Question: Judging by this figure, is the value going up or going down?
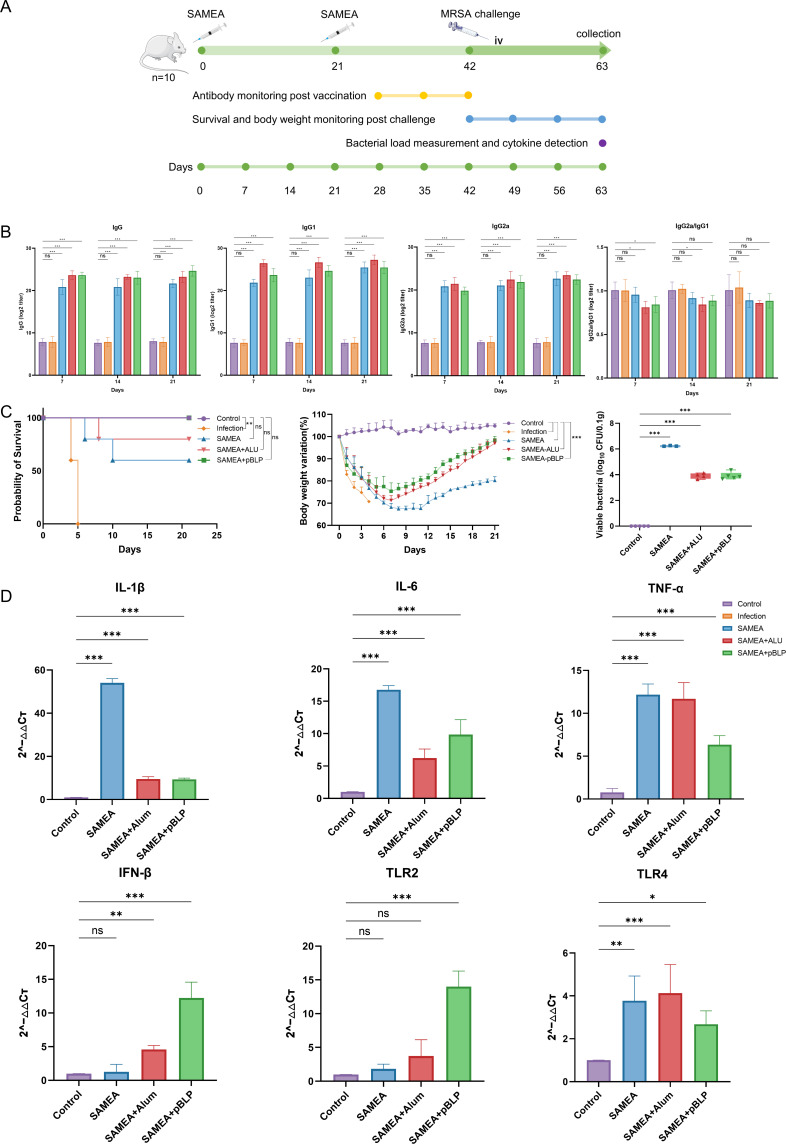
Answer: increasing